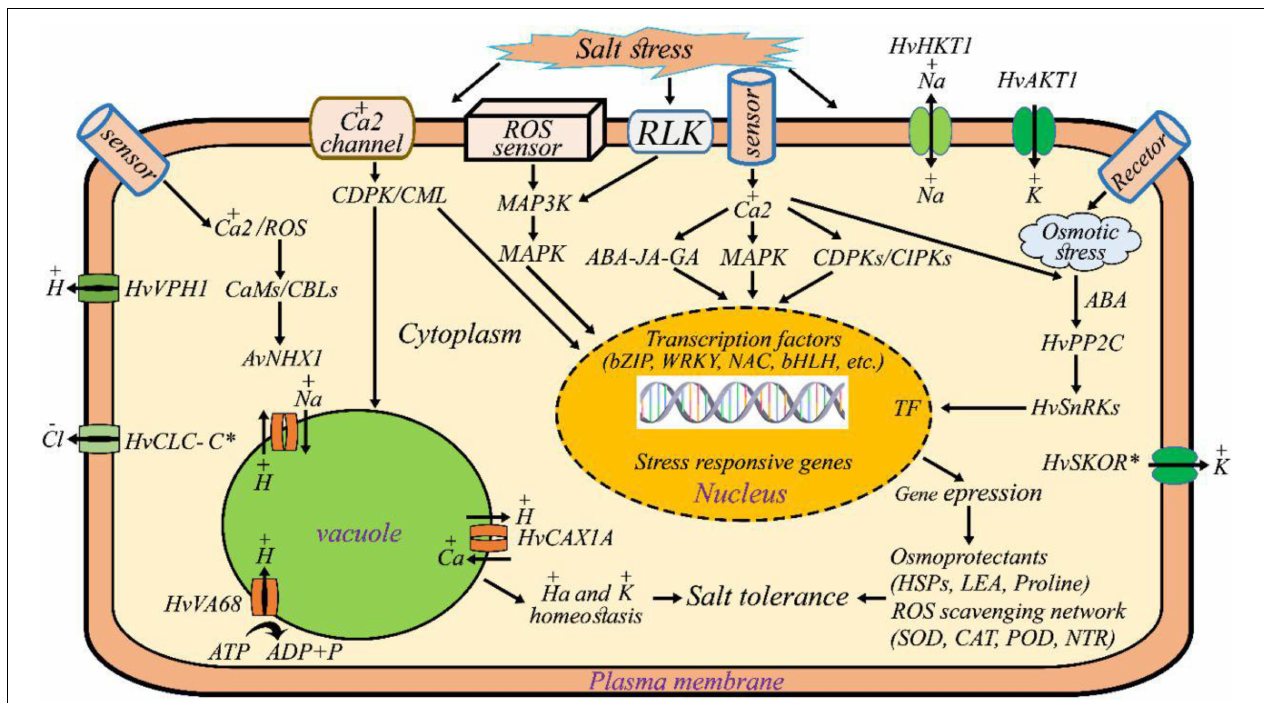
FIGURE 7 | Salt tolerance mechanisms of wild barley ( H. vulgare ssp. spontaneum ). Wild barley maintains lower cellular Na + content by activating ion transporters such as NHXs (sodium exchanger), CLC-C (chloride channel protein), SKOR (outward rectifying K + ), AKT (inward rectifying K + ), HKT (high affinity potassium transporters) and CAX (vacuolar cation/proton exchanger). Thus, ion transporters associate with maintaining K + /Na + ratio in salt tolerant (wild) plant. Vacuolar H + -ATPase establishes a proton gradient across the vacuolar membrane that drives vacuolar Na + /H + exchanger activity. Several key components including